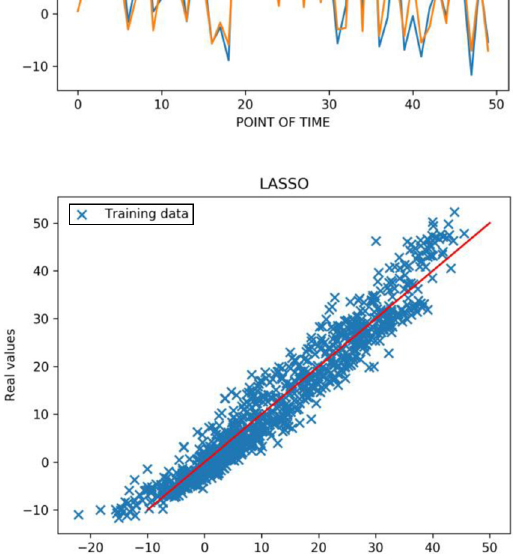
Figure 7. Regression plot for data samples with